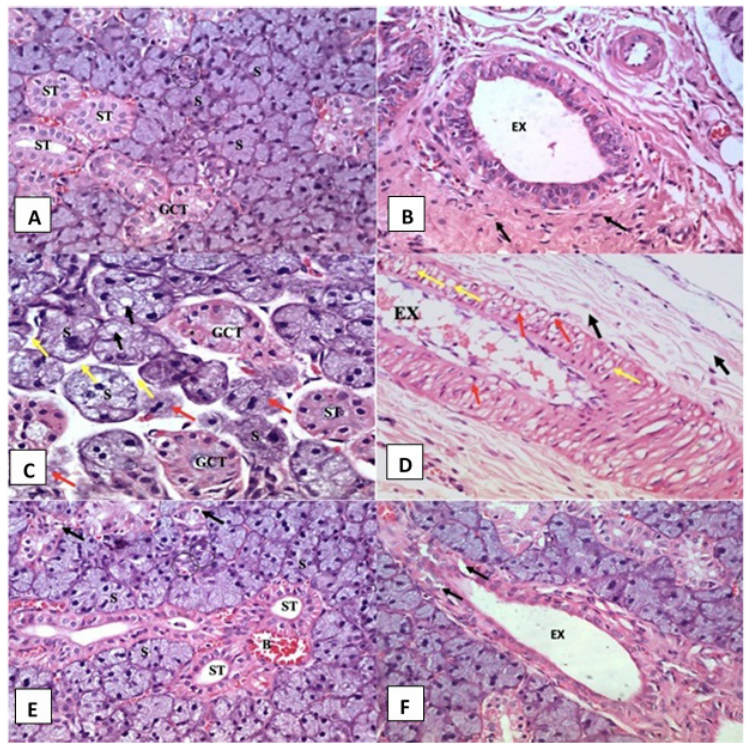
Figure 1. Photomicrographs of haemotoxylin and eosin (H&E) stained sections in submandibular salivary glands. ( A , B ) Control group showing regular gland architecture of serous acini (S) intercalated duct (circle), granular convoluted tubule (GCT), striated duct (ST) and excretory duct (EX) surrounded by fibrous connective tissue stroma (arrows) (H&E orig. mag x 400). ( C , D ) AFB1 treated group showing remnants of degenerated acini (red arrows), atrophic serous acini (S) with cytoplasmic vacuolation (black arrows), wide interacinar spaces (yellow arrows), vacuolated GCT and striated duct (ST) and excretory duct (EX) with thickened lining epithelium presenting extensive vacuolations (yellow arrows) and some crescent shaped nuclei in its cells (red arrows). Degenerated areas are seen in the surrounding fibrous connective tissue stroma (black arrows) (H&E orig. mag x 400). ( E , F ) Rosemary treated group showing normal serous acini (S), intercalated ducts (circle), GCT with few cytoplasmic vacuoles (arrows) and striated ducts with normal cell lining (ST). Dilated and congested blood vessels were observed (B) and excretory duct (EX) shows relatively normal lining with slight vacuolations in some areas (arrow) (H&E orig. mag x 400)